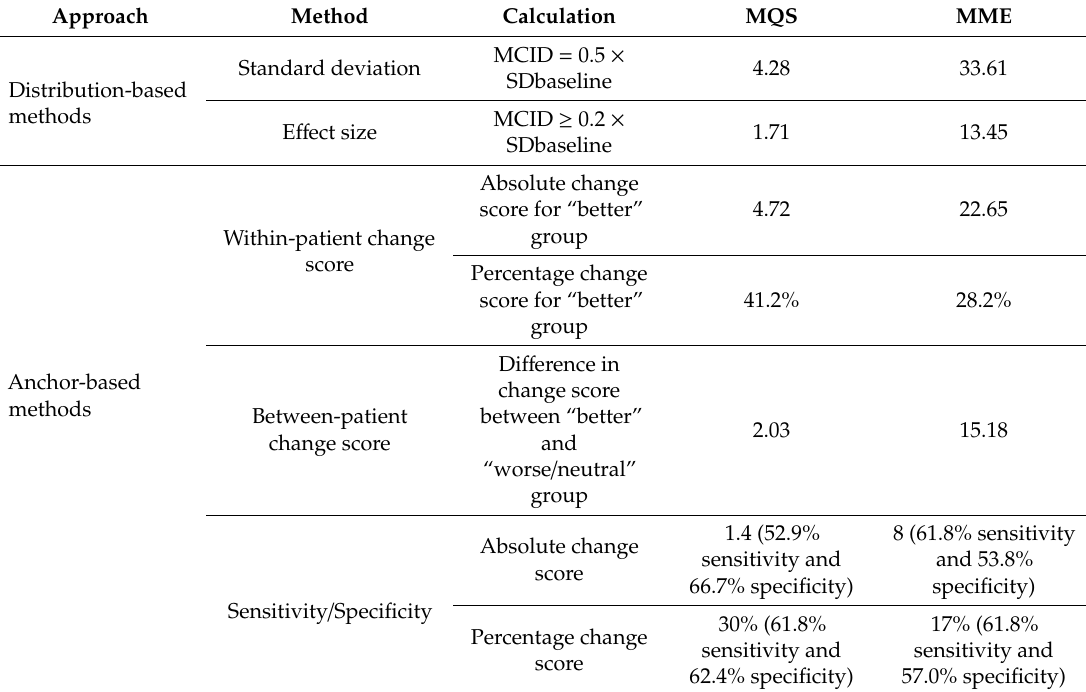
Table 1. Distribution- and anchor-based proposed MCID values for the MQS and MME in patients with FBSS after treatment with high-dose spinal cord stimulation